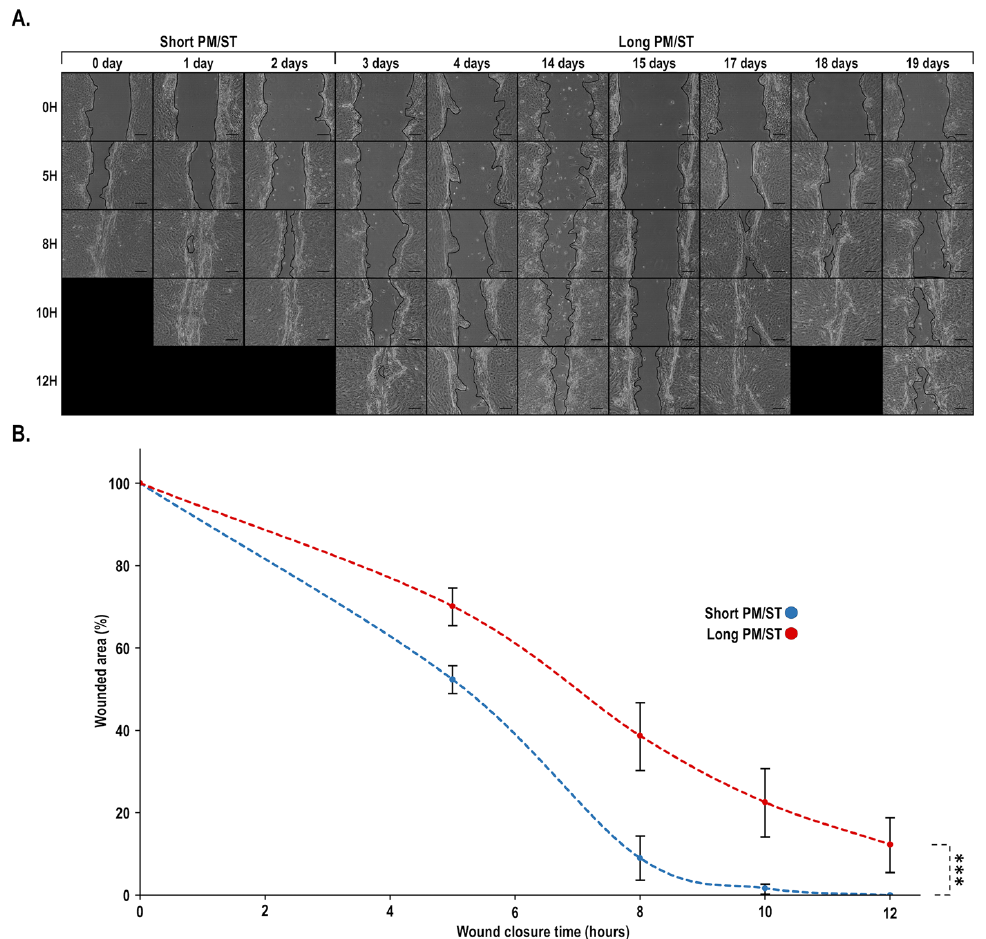
Figure 4. Impact of PM/ST on wound closure of hLECs grown in monolayer. ( A ) hLECs with different PM/STs grown as a monolayer were wounded and allowed to migrate until 12 h postwounding. Scratches (four per condition) were photographed at various time intervals (0 to 12 h) to monitor wound closure. ( B ) Wound surfaces remaining for each condition were determined at various time intervals (0, 5, 8, 10, 12 h) and plotted on a graph. Scale bar: 200 µ m. p -value: *** < 0.001.